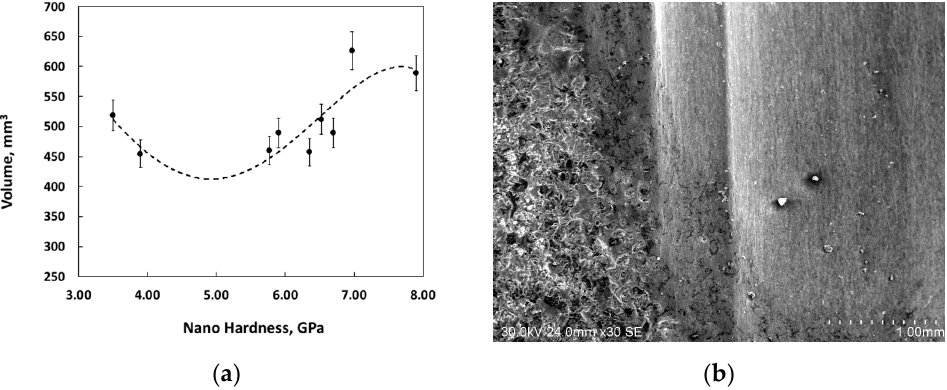
Figure 6. Results of abrasive test. ( a ) Volume graph shifted vs. nanohardness; ( b ) SEM micrography of the traces left in the abrasion test on the coatings 359 kPa oxygen 83 kPa acetylene.